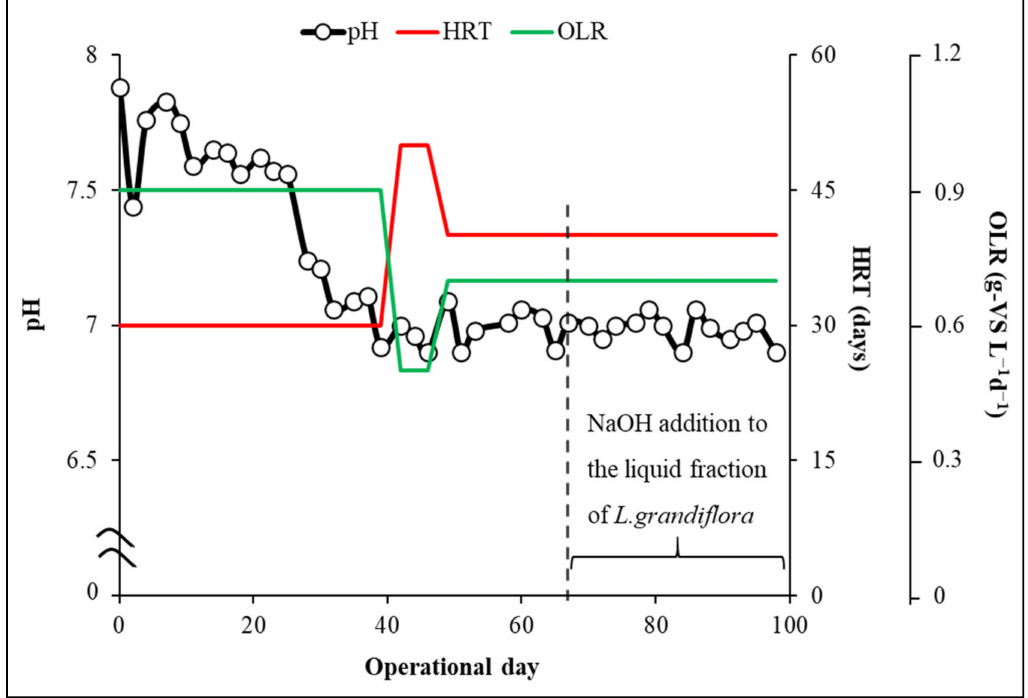
Figure 3. Relationship of the pH with HRT and OLR during the AD